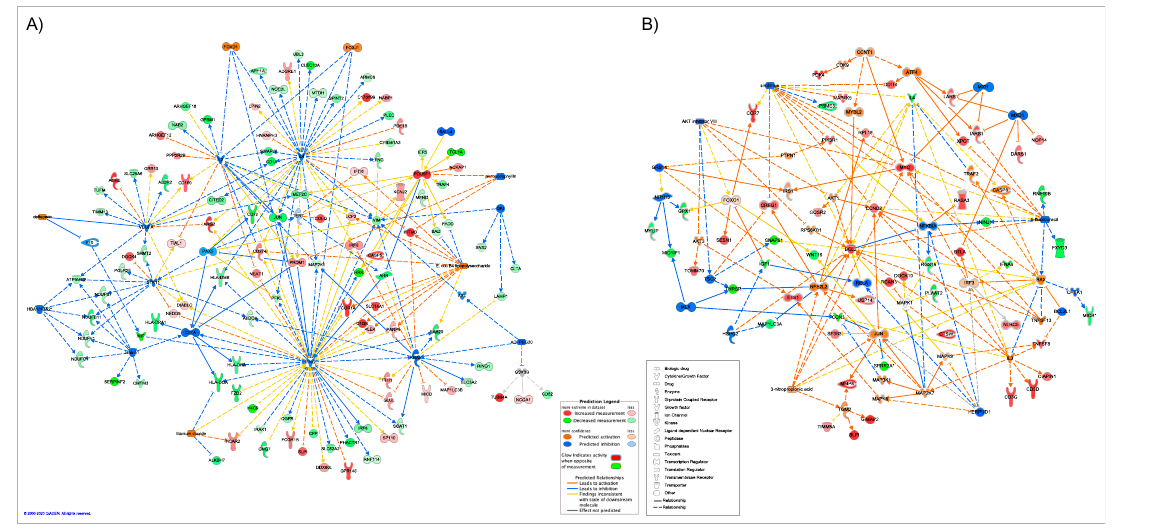
Figure 7. Causal Network analysis of interacting master upstream regulators based on differentially expressed genes in the OPTIMISTIC and DMBDI datasets. Causal networks of “significant” master regulators and their target genes are shown for ( A ) OPTIMISTIC and ( B ) DMBDI datasets.